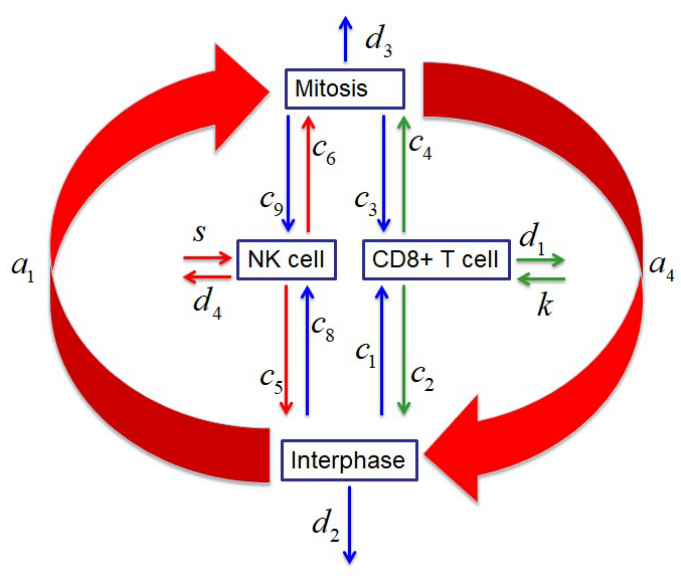
Figure 1. Flow chart of Tumour-NK and CD8 + T cells interaction